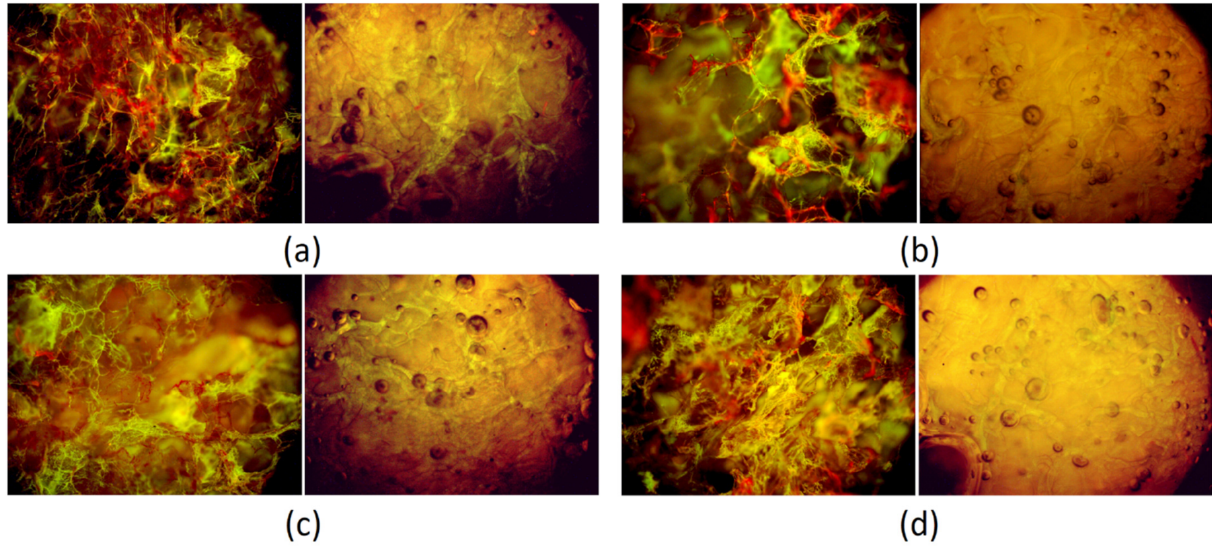
Figure 13. Microphotographs of the hydrogels ( a ) Gel-1 dried and swollen; ( b ) Gel-2 dried and swollen; ( c ) Gel-3 dried and swollen; ( d ) Gel-4 dried and